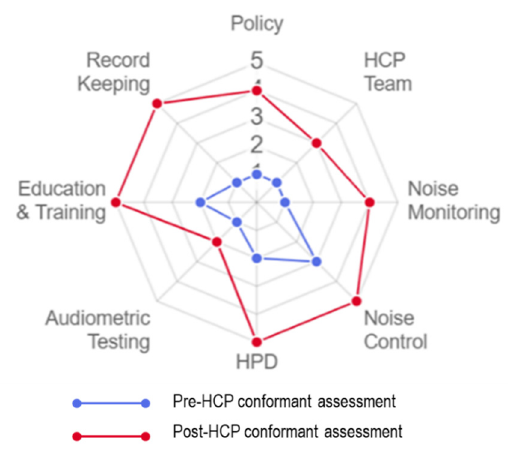
Figure 3. Visual representation of pre- and post-OHCI system.